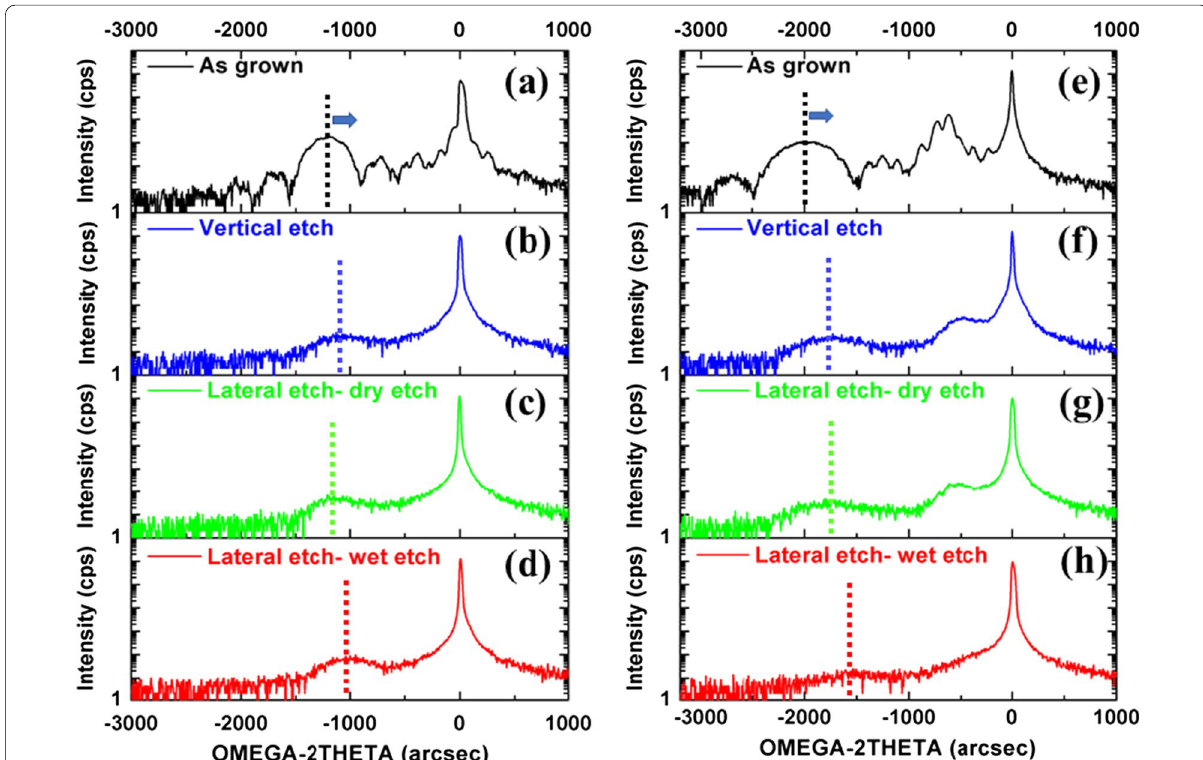
Fig. 8 HRXRD rocking curve around (004) reflection of sample-1, P-doped Si/Si 0.86 Ge 0.14 /P-doped Si MLs with 5 nm spacer layer in a – d , and sample-2, P-doped Si 0.93 Ge 0.07 /Si 0.78 Ge 0.22 /P-doped Si 0.93 Ge 0.07 MLs in e – h . Both the two samples have four panels: as grown, after vertical etch, SiGe lateral wet etch of HF (6%)/H 2 O 2 (30%)/CH 3 COOH (99.8%) 20 min, and lateral dry etch of CF 4 /O 2 /He 11.5